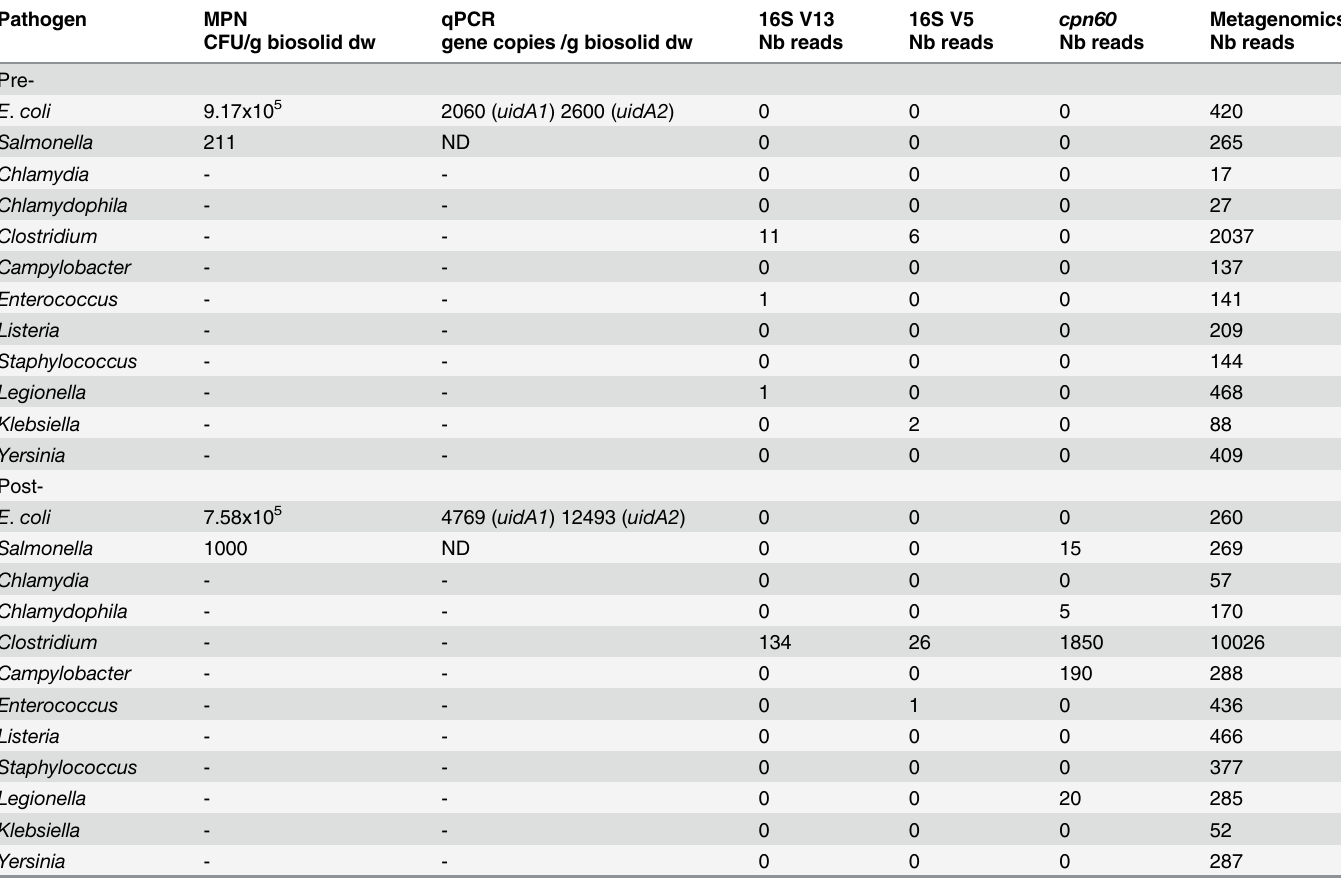
Table 8. Detection of selected selected species/genera containing pathogenic strains in biosolids from Plant A on August 4,